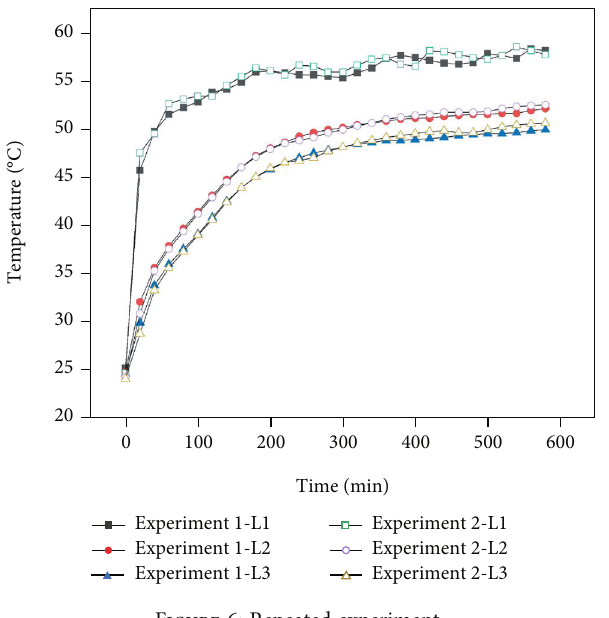
Figure 6: Repeated experiment.